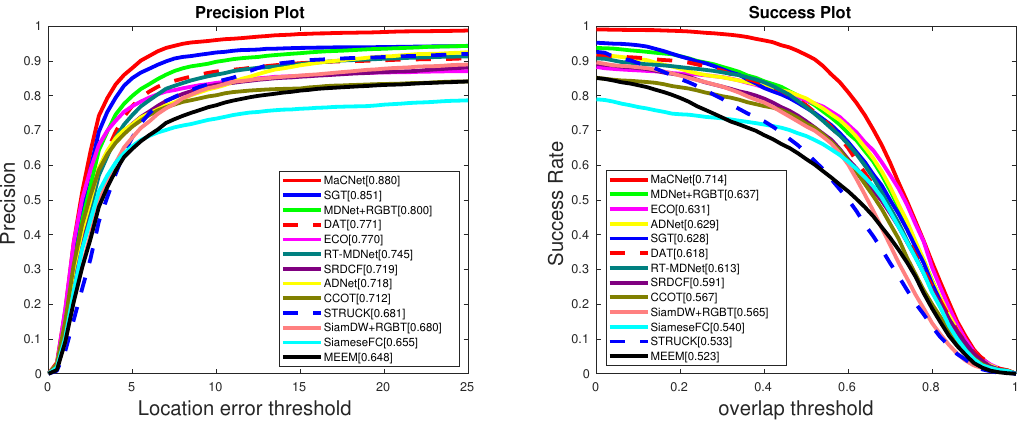
Figure 3. Precision rate (PR) and success rate (SR) curves of different tracking result on GTOT dataset [12], where the representative PR and SR scores are presented in the